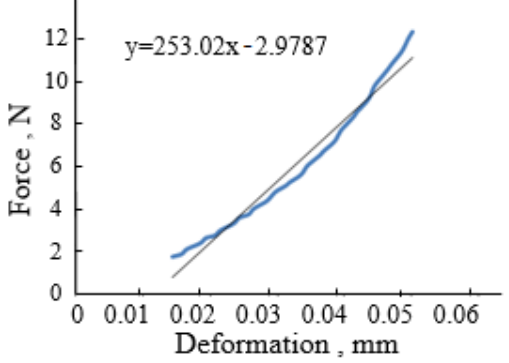
Figure 2. The force – deformation relationship of SN42 soybean seeds.